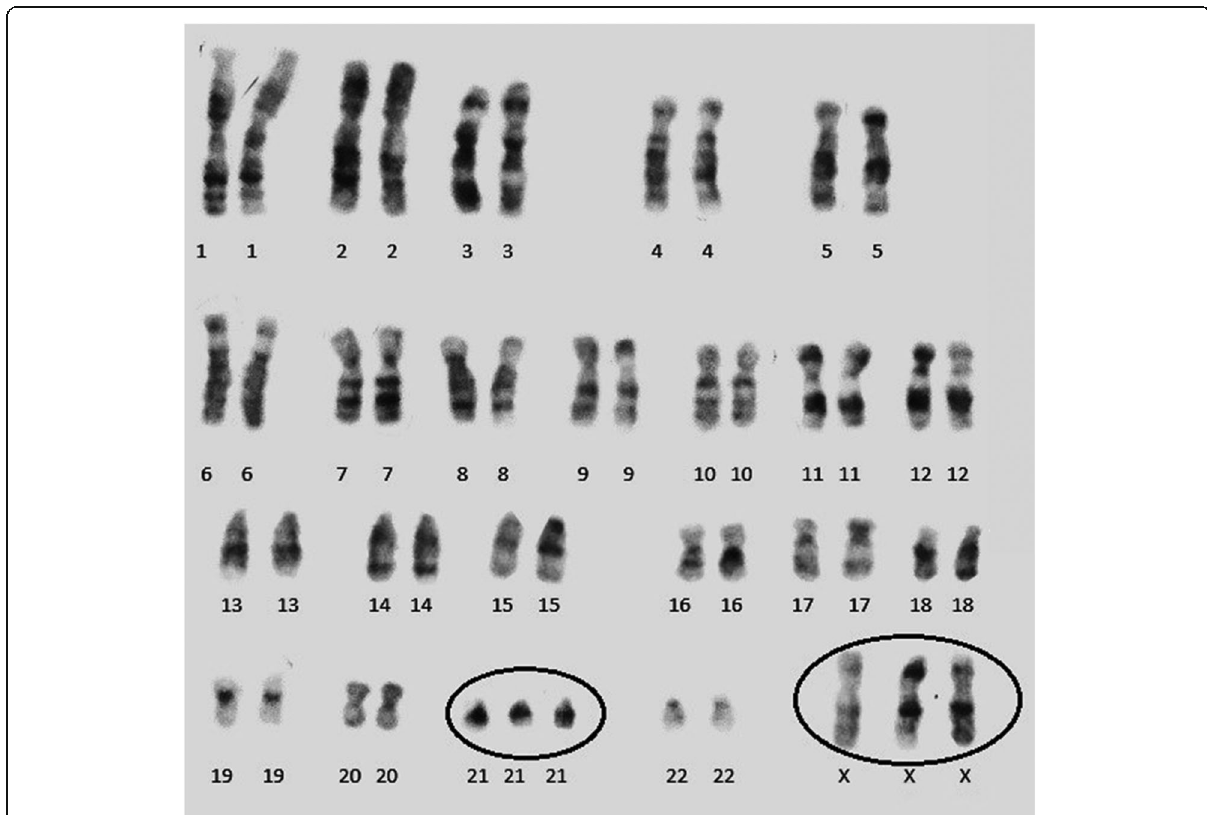
Fig. 2 Gimsa-banded metaphase chromosomes of the patient: 48, XXX, +21. Circles indicate the additional copies of chromosome 21 and X